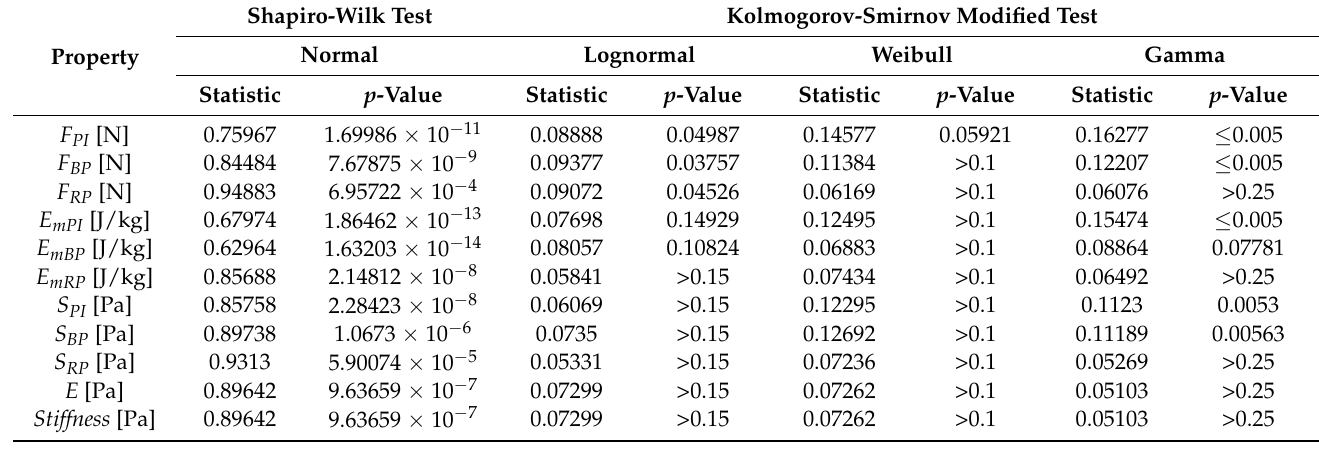
Table 6. Results of distribution of the goodness-of-fit tests.